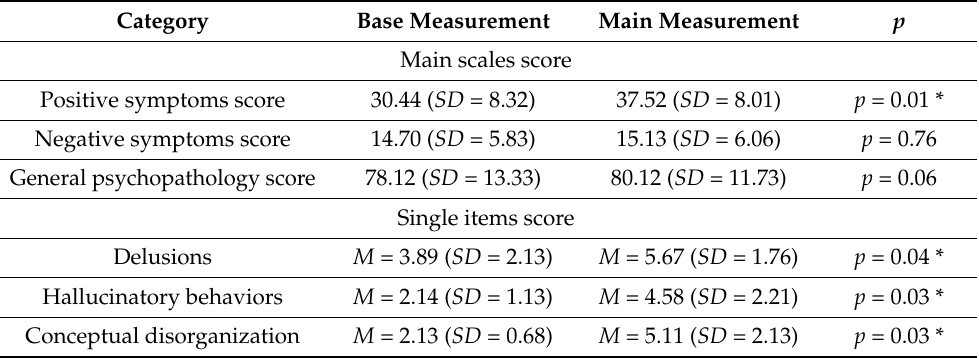
Table 3. Comparison of results in PANSS scales and single items between the main and base measurement (before and after exposure to RUW).